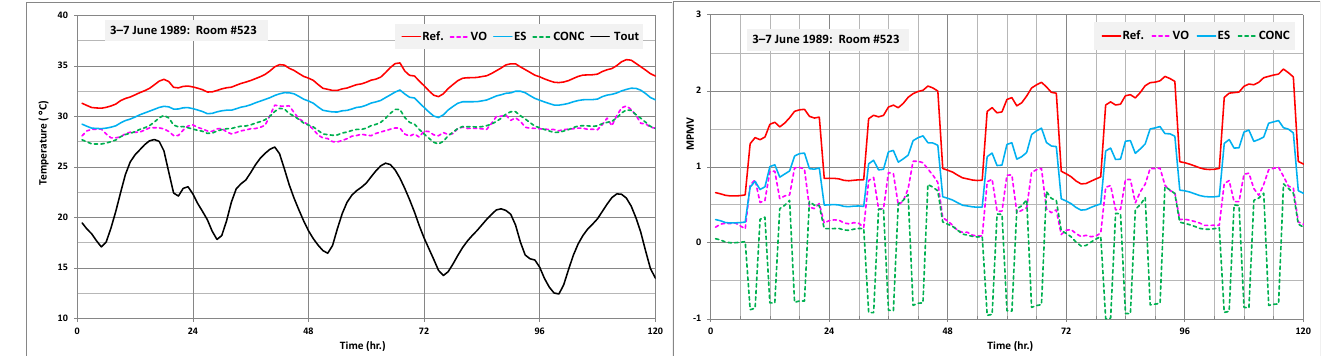
Figure 13. Bedroom temperature and thermal comfort of residents in new LTCHs.